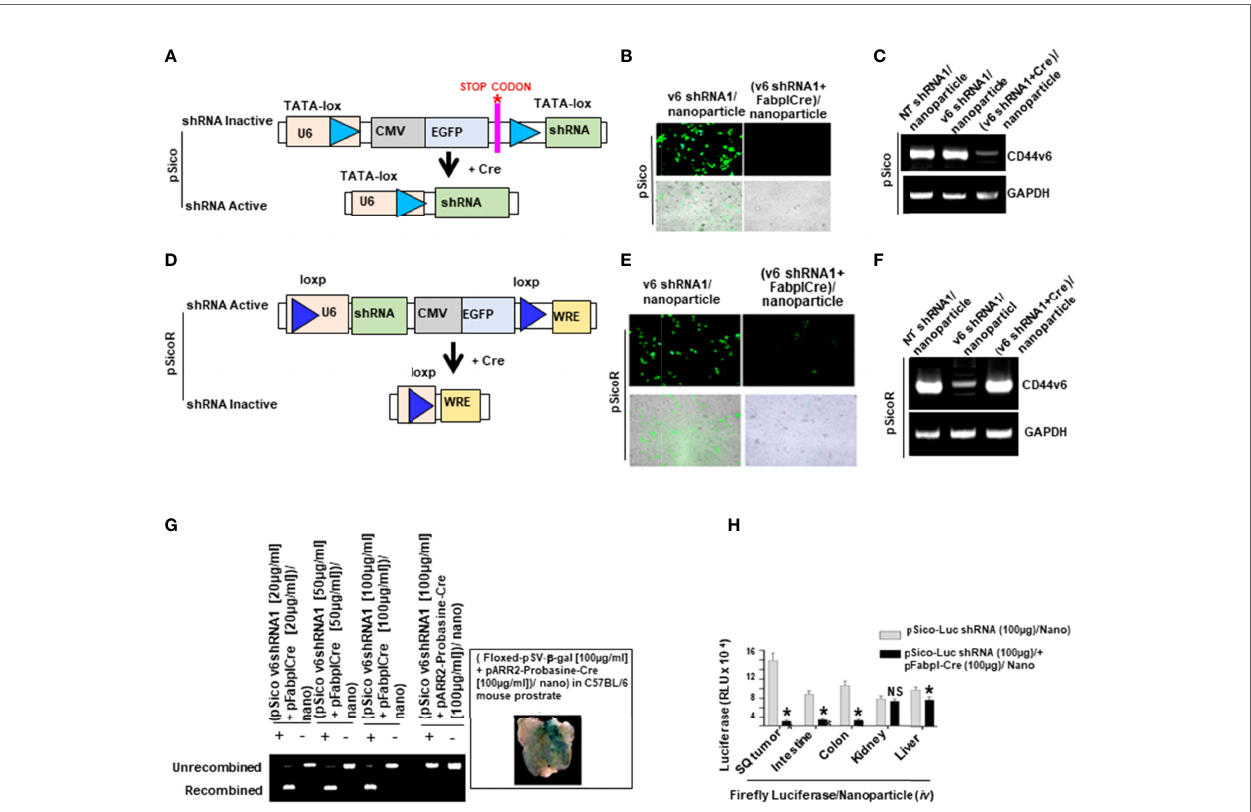
FIGURE 9 | Con fi rming the inducible CRE system used tissue speci fi c knockdown of CD44v6 to inhibit subcutaneous (SQ) tumor growth. (A – D) , Schematic representations of pSico, and pSicoR after Cre-mediated recombination to synthesize active shRNA are shown. (B – E) , SW480-FR/SQ tumor cells from the transfection of the cells with (pSico-v6shRNA1 plus the pFabpl-Cre)/transferrin (Tf)-PEG-PEI) (Nanoparticles [Nano]) and with the (pSicoR-v6shRNA1 plus pFabpl- Cre)/Nano and were analyzed by epi fl uorescence microscopy to detect GFP. Similar cell densities and identical exposure times were used for all images. (See Materials and Methods for details in nanoparticles). (C, F) , Total RNAs extracted from the transfected cells were analyzed for CD44v6 and GAPDH mRNAs by semi- quantitative PCR. (G) , SW480-FR cells were transfected with pSico v6 shRNA plus Fabpl-Cre/Nano, or with pSicoR v6shRNA plus Fabpl-Cre/Nano. PCR detection is shown for Cre-mediated recombination of pSico-CD44v6 shRNA in tumor Genomic DNAs extracted from mice 4 days after shRNA plus indicated Cre/Nano treatments to xenograft tumors induced by SW480-FR cells. (# of mice/experiment = 5; # of experiments = 2). Note that pSico v6 shRNA plus Probasin Cre/Nano did not have any effect on colon tumors. Inset shows the functionality of Floxed-pSV b -galactoside/ plus pARR2-Probasin Cre/nanoparticles in the prostate gland. (H) , Validation for tissue speci fi c delivery of shRNA/nanoparticles was done by verifying distributions of shRNA against the fi re fl y luciferase gene (pSico-Fire fl y luciferase shRNA plus pFabpl-Cre)/Nano, and are shown in various organs of C57/Bl mice (n = 4), which were previously injected with reporter plasmids expressing fi re fl y luciferase and renilla luciferase (i.p.). The luciferase activities of the tumor extracts and the indicated tissues were measured. Note that luciferase-shRNA is active in colon tumors and in normal colon and intestine tissues due to the functionality of pFabpl-Cre. Data presented are Mean ± SD.; n = 5 mice/group independent replicates in two (G) and three (H) independent experiments. All semi quantitative RT-PCR and Epi fl uorescence microscopy data are representative of three experiments. (H) , *, P < 0.05 was considered signi fi cant, inhibition in luciferase activity in (pSico-Luc sh (100 m g) + pFabpl-Cre (100 m g))/ Nano compared to pSico-Luciferase shRNA (100 m g)/Nano group. Student ’ s t-test was used to assess the signi fi cance in (H)